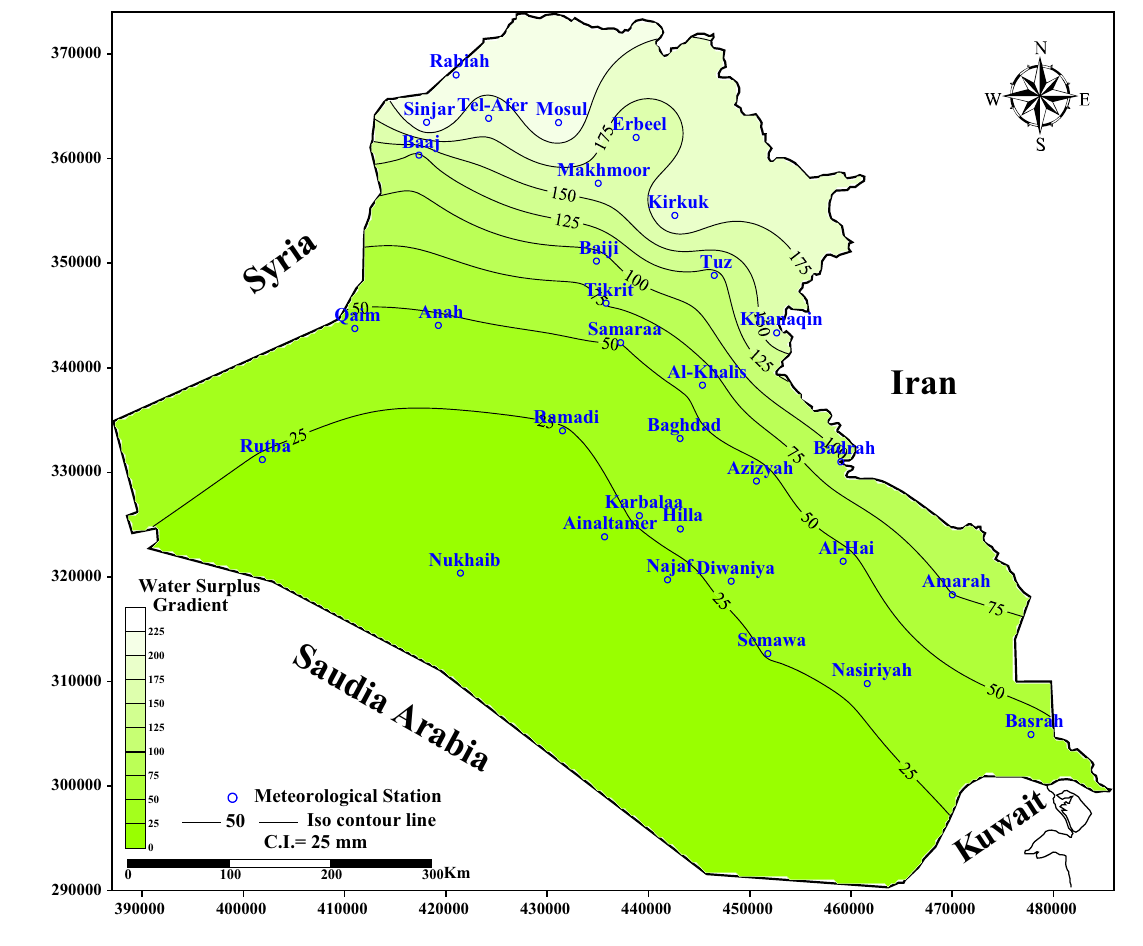
Fig. 4 Contour map of annual water surplus (WS) in Iraq